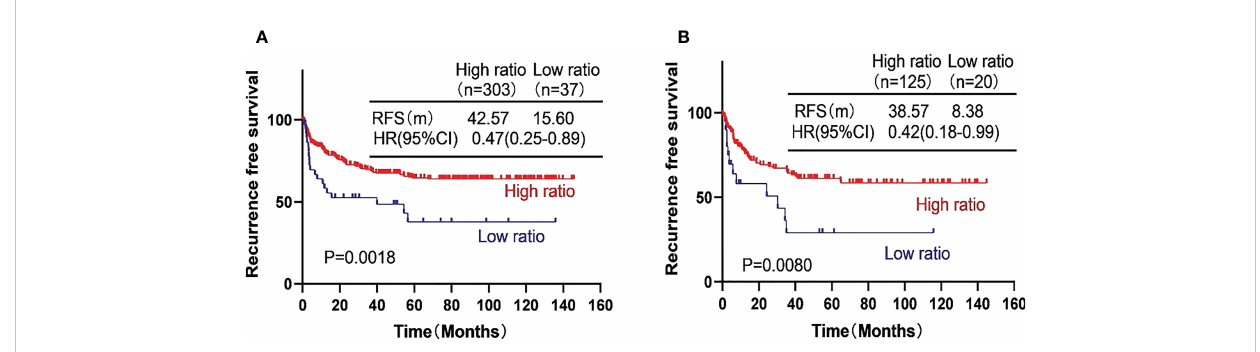
FIGURE 2 Kaplan-Meier curves showing the recurrence free survival (RFS) of the high-risk subgroup and the low-risk subgroup of hepatocellular carcinoma patients in the training cohort (A) and the validation cohort (B) .